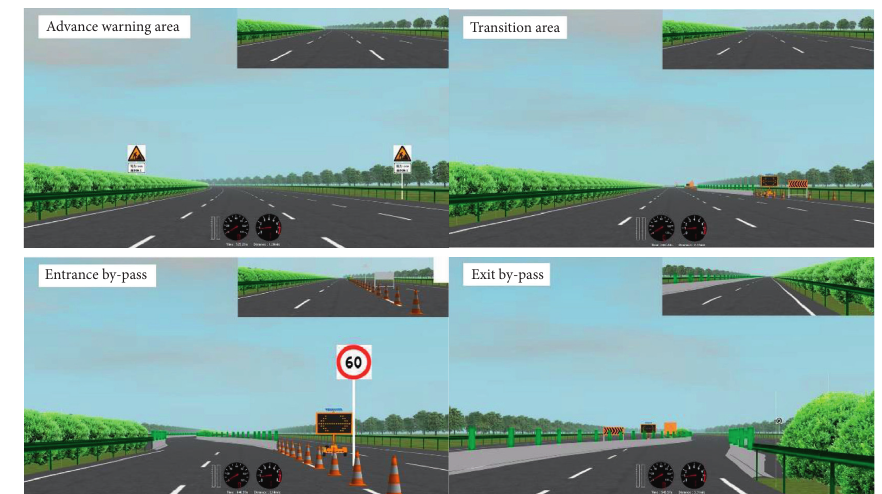
Figure 2: Traffic control zone reference